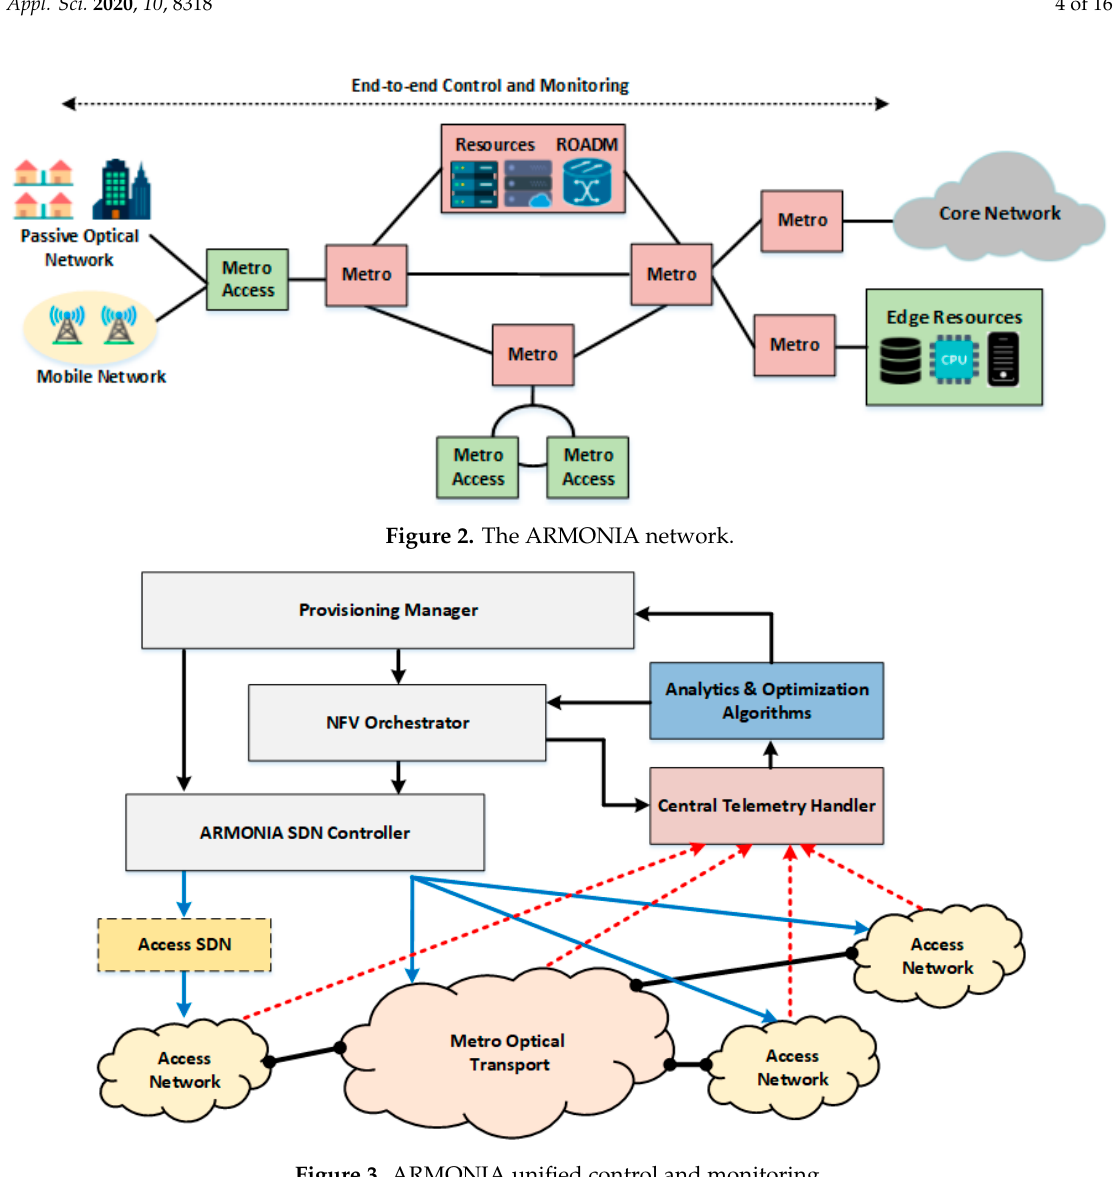
Figure 3. ARMONIA unified control and monitoring.